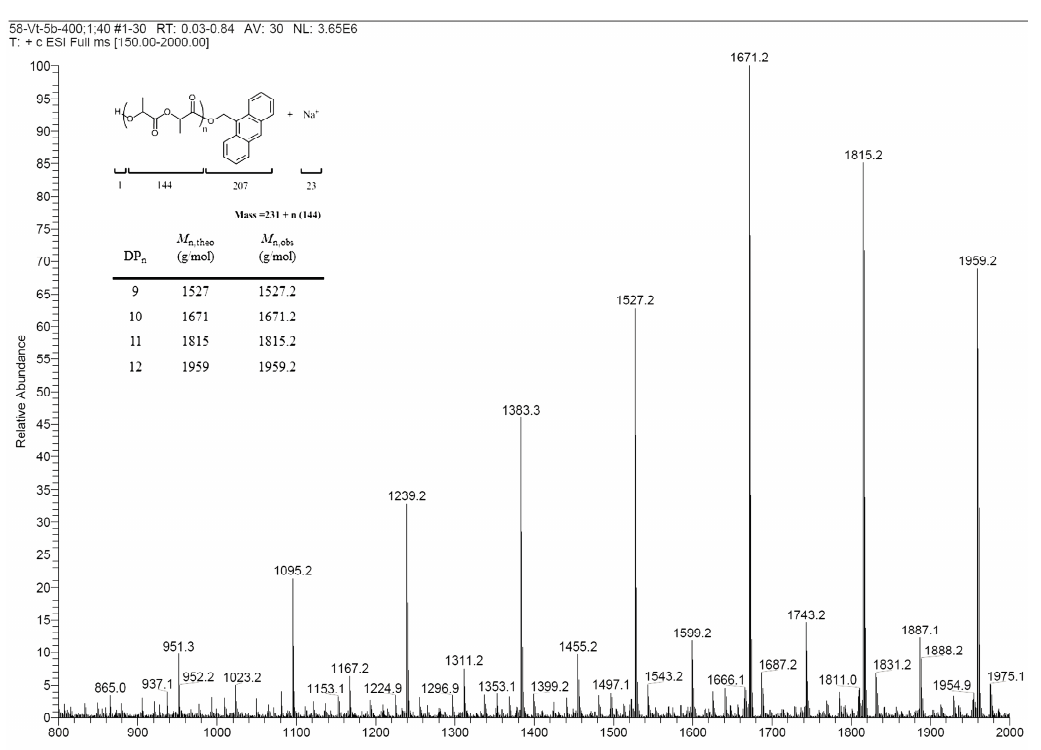
Figure 6. ESI-MS of 9-AnO-PLLA-H (Table 1, entry